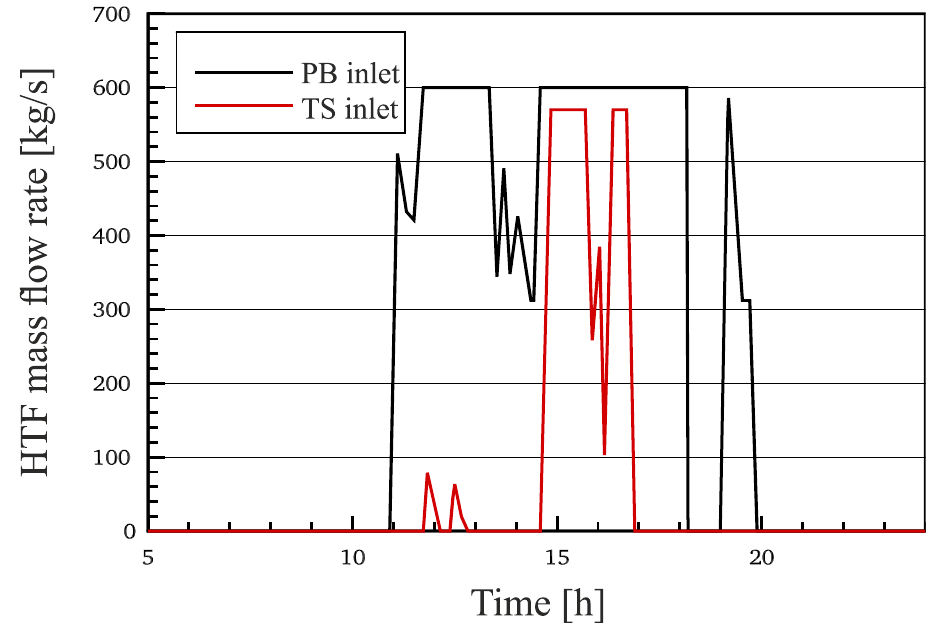
Figure 6. Simulated results of HTF mass flow rate to the PB and to the TSS.